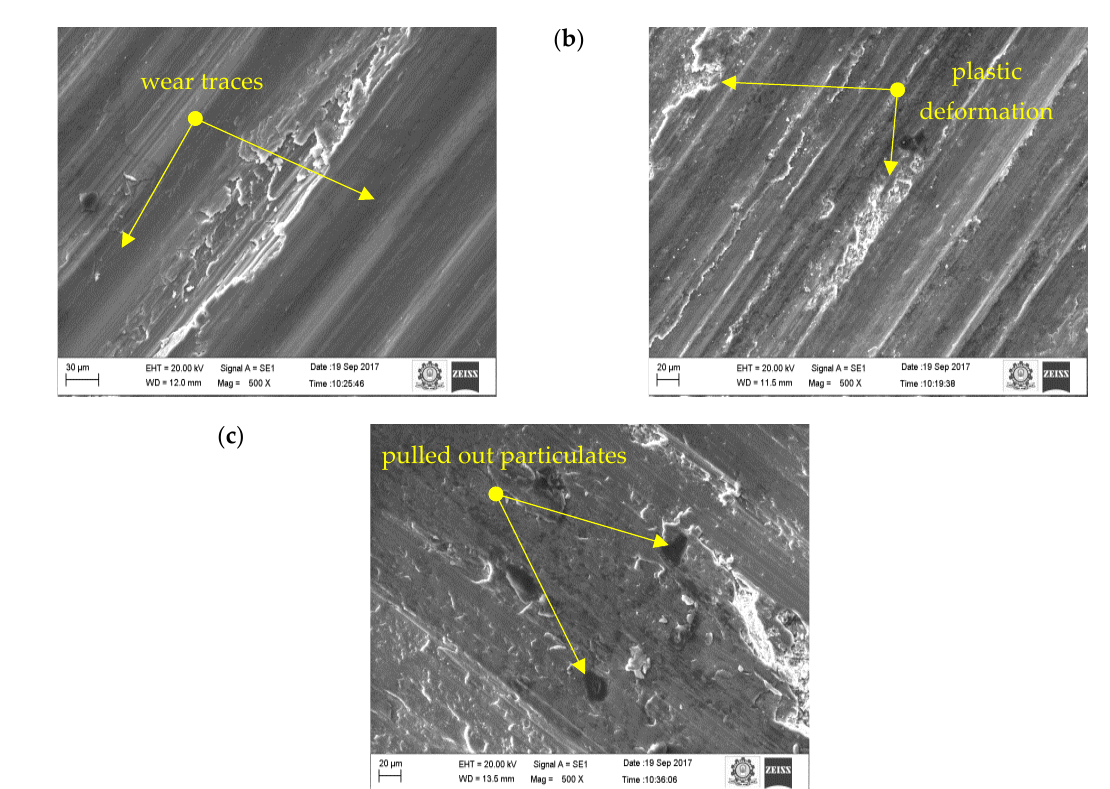
Figure 12. Worn surface morphology (SEM images) of the 10 wt.% composite: ( a ) 0.75 m/s, ( b ) 1.5 m/s, ( c ) 2.25 m/s.